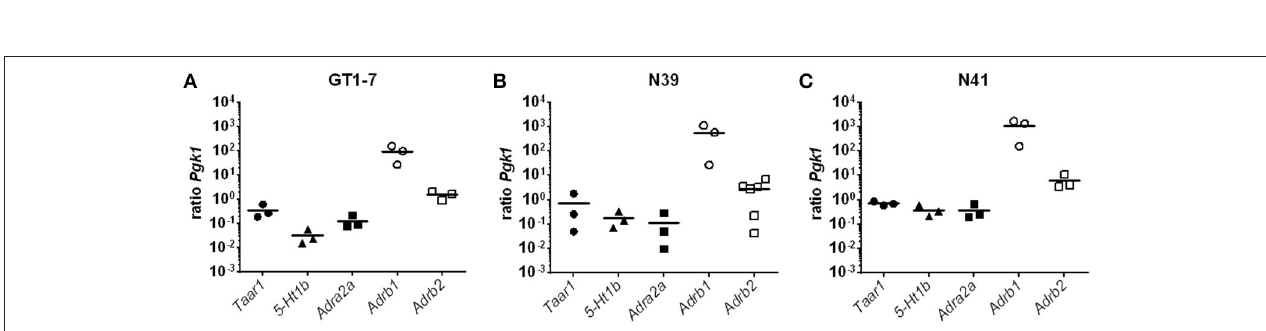
FIGURE 2 | Expression pattern of GPCRs in N39, N41 and GT1-7. Results of a SYBR Green based qPCR. Graphs show the ratios between the reference gene Pgk1 and the GPCRs Taar1 , 5-Ht1b , Adra2a , Adrb1, and Adrb2 . Data was pooled from ( n = 3) measured in duplicates. ( A ) Adrb1 and Adrb2 have the highest expression, while 5-Ht1b has the lowest in GT1-7 cells. ( B ) In N39 cells, Adrb1 has the expression ratio compared to Pgk1 , followed by Adrb2 . 5-Ht1b and Adra2a are at least abundant in N39 cells. ( C ) Among the measured GPCRs Adrb1 has the most copies of mRNA in the transcriptome of N41 cells, once again followed by Adrb2 . However, Taar1 , 5-Ht1b, and Adra2a are rather equimolar to Pgk1 .